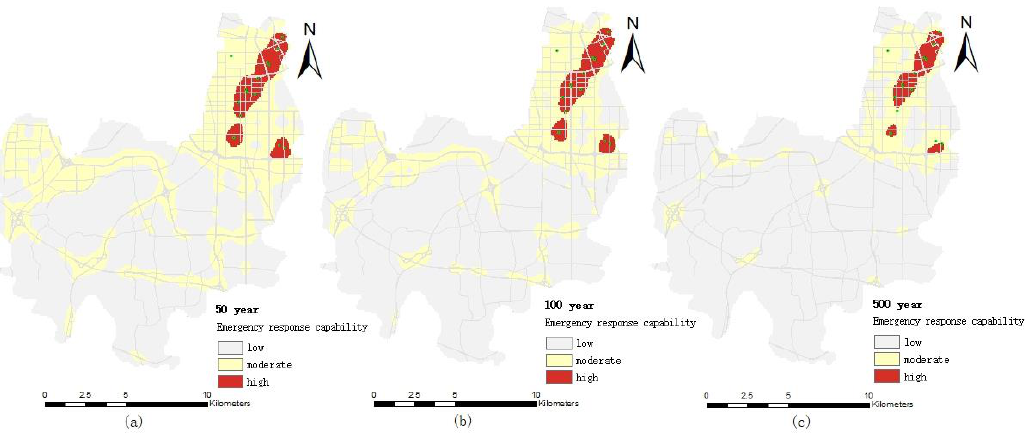
Figure 7. Distribution of emergency response capability of firefighting institutions under different pluvial flooding scenarios: ( a ) the 50-year pluvial flooding scenario; ( b ) the 100-year pluvial flooding scenario; ( c ) the 500-year pluvial flooding scenario.